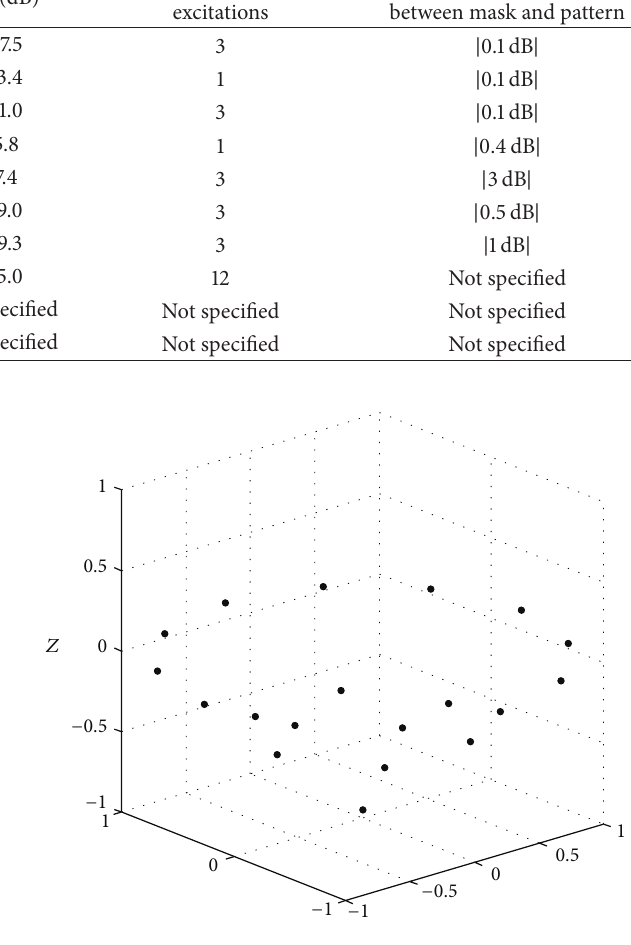
Figure 8: Element distribution of VRA for LEO satellites with concentric